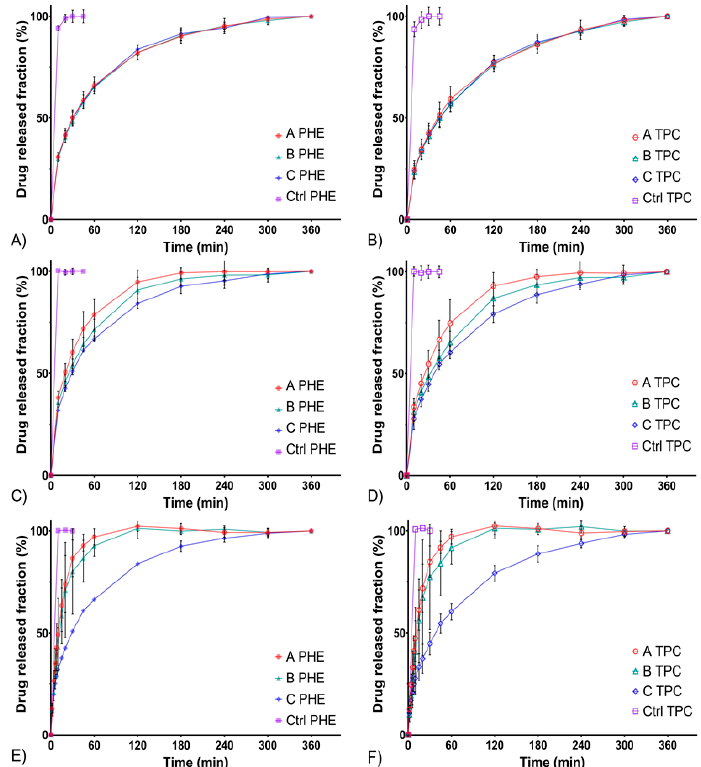
Figure 1. In vitro drug release profiles from formulations A, B, and C compared with a liquid control solution using the USP 4 standard flow through cells. PHE release profiles at 3 mL / min ( A ), 8 mL / min ( C ), and 15 mL / min ( E ) flow rates. Tropicamide (TPC) release profiles at 3 mL / min ( B ), 8 mL / min ( D ), and 15 mL / min ( F ) flow rates.